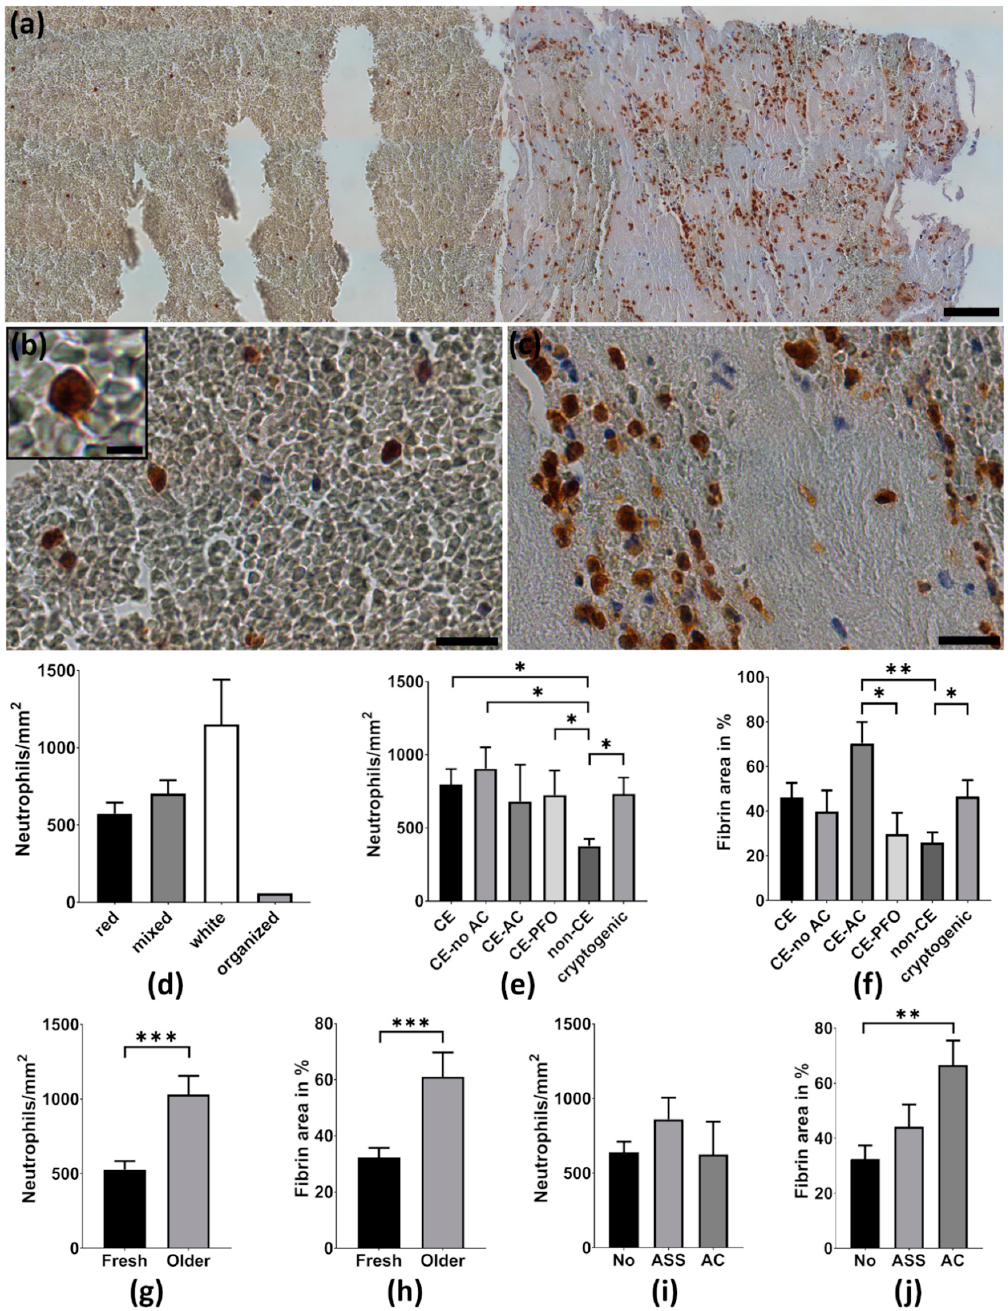
Figure 2. Neutrophils and structural composition in thrombemboli. ( a ) Representative image of an anti-CD66b stained thrombemboli displaying histopathological heterogeneity. Nuclear cells (dark blue) are counterstained with hemalum staining. ( b ) Magnifications of red blood cell (RBC)-dominant area with additional magnification (scale bar 10 µm) of a neutrophil in the upper left corner and ( c ) fibrin-dominant area illustrating specific structural accumulation behavior of neutrophils. ( d - j ) Quantitative analysis of neutrophils and fibrin area regarding ( d ) thrombemboli morphology, ( e , f ) stroke etiology, ( g , h ) thrombembolus age and ( i , j ) patients’ premedication without anticoagulant therapy (No), with acetylsalicylic acid (ASA) or with pre-existing anticoagulation (AC). CE = cardioembolic, CE-no AC = cardioembolic without anticoagulation, CE-AC = cardioembolic with anticoagulation, CE-PFO = cardioembolic with patent foramen ovale, non-CE = non-cardioembolic. * p < 0.05, ** p < 0.01, *** p < 0.001. Scale bars: ( a ) 100 µm, ( b , c ) 20 µm.